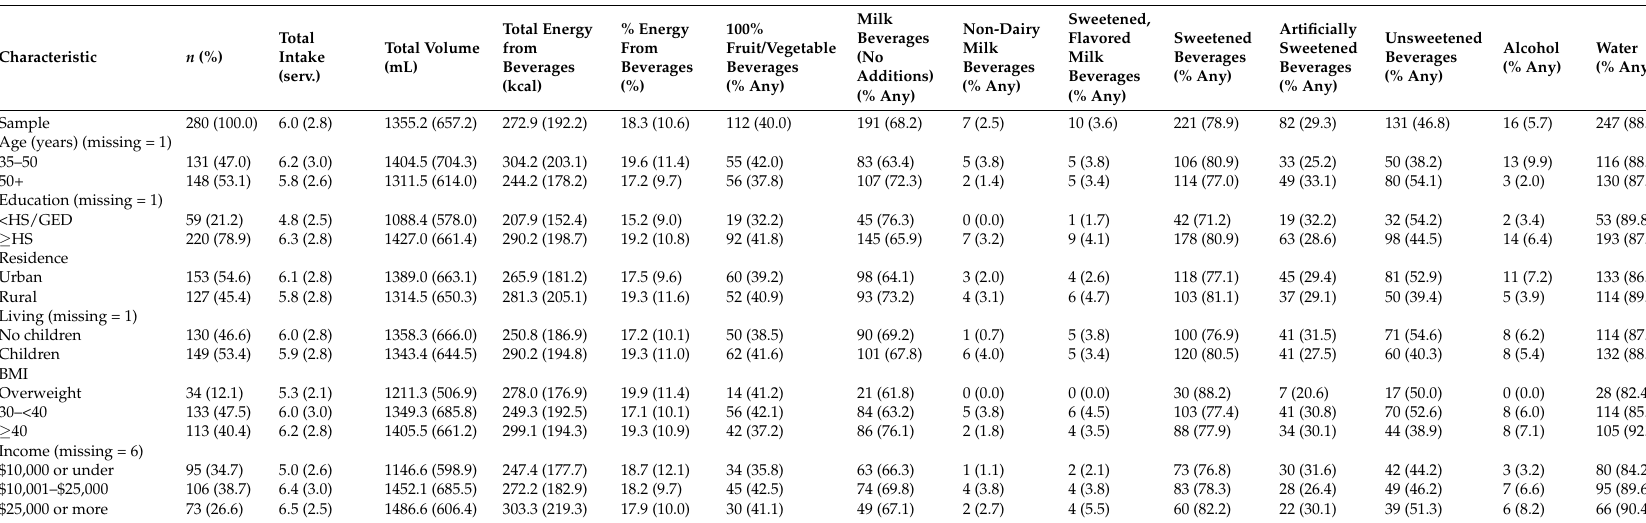
Table 1. Total Beverage Consumption (Mean and Standard Deviation -SD) and Percent Reporting Any Consumption (%) of Selected Subgroups of Beverages, by Participant Characteristics.